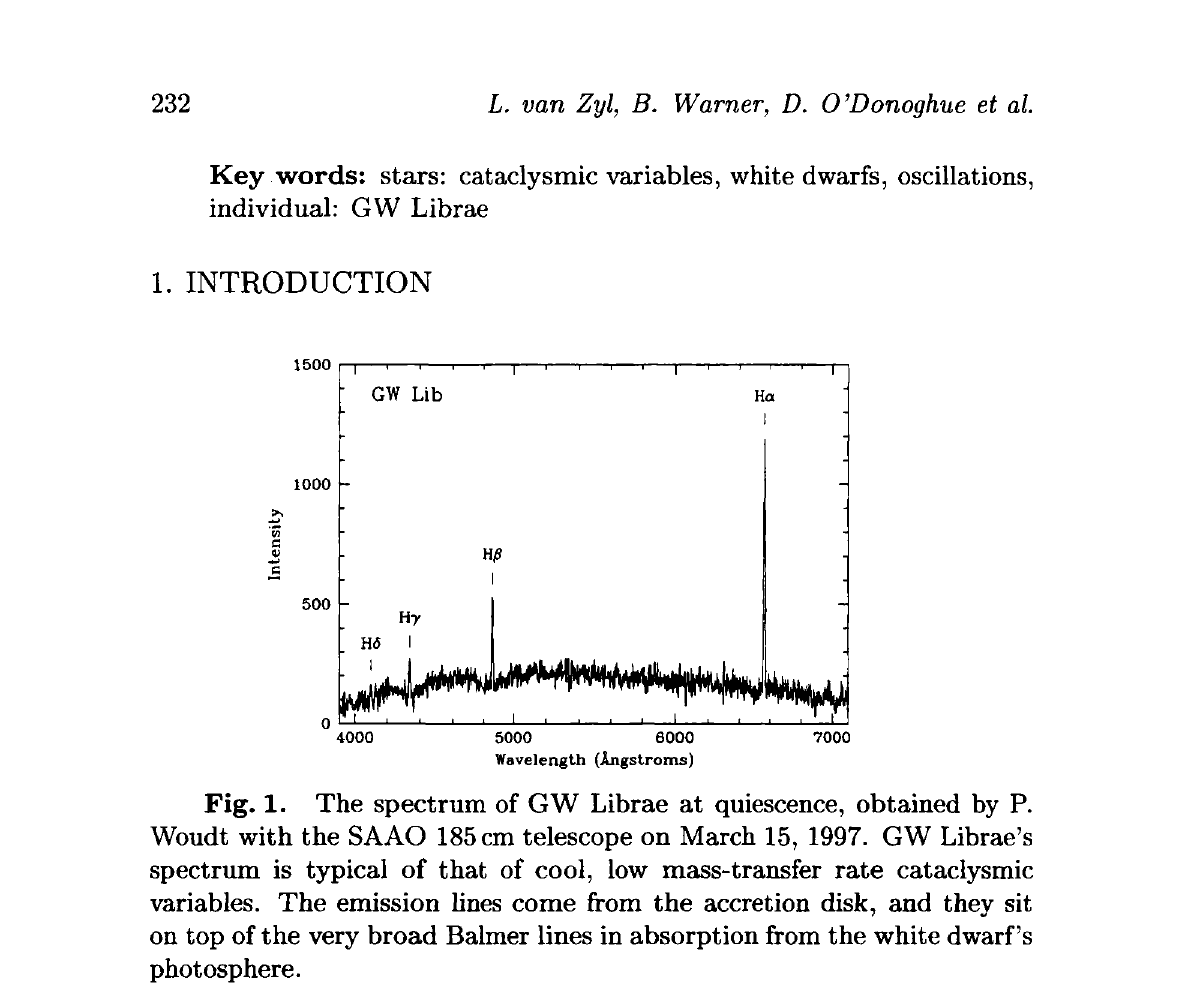
Fig. 1. The spectrum of GW Librae at quiescence, obtained by P. Woudt with the SAAO 185 cm telescope on March 15, 1997. GW Librae's spectrum is typical of that of cool, low mass-transfer rate cataclysmic variables. The emission lines come from the accretion disk, and they sit on top of the very broad Balmer lines in absorption from the white dwarf's